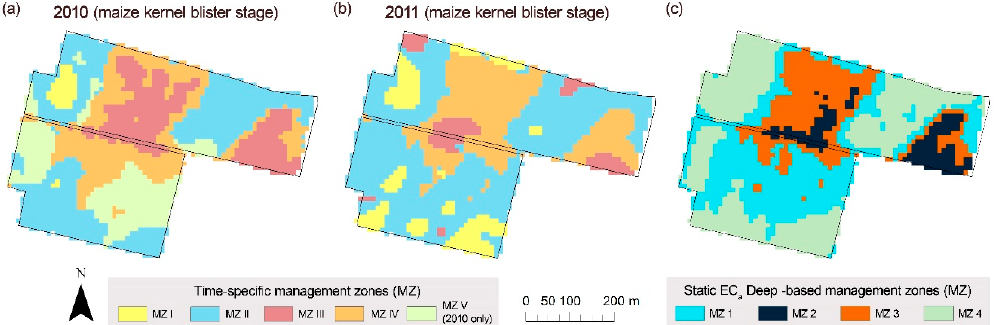
Figure 5. In-season delineation of time-specific management zones (MZs) for maize late kernel blister stage of ( a ) 2010 and ( b ) 2011. ( c ) Static MZ designs using soil apparent electrical conductivity for the 0–1.5 m soil profile (EC a Deep) only.